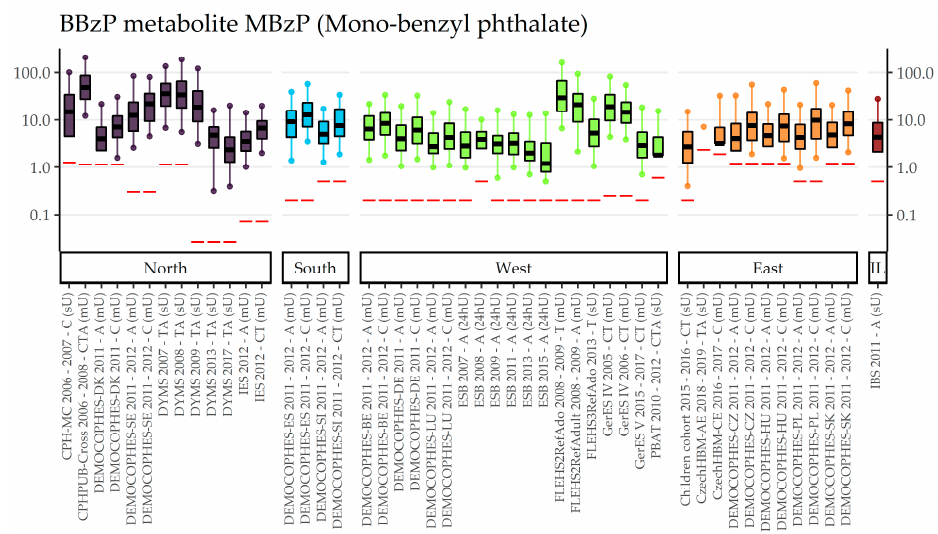
Figure 1. BBzP metabolite MBzP concentration in µ g/L in boxplots. The box is based on P25, P50, and P75, and the whiskers are based on P5 and P95. Boxplots are presented separately by regions (North = violet, South = blue, West = green, East = orange, Israel = dark red) within the regions chronologically sorted by year of sampling. Red lines denote LOQ/LOD for the respective study. Since percentiles are only available and displayed when they are above LOQ/LOD, the lower side of boxplots might be truncated. The age categories are shown in capital letters: children of the age groups 3–5 and 6–11 (C), adolescents between 12 and 19 years (T) and adults from the age groups 20–39, 40–59 and 60 years and older (A). The sampling method is indicated in brackets: first morning urine void (mU), spot urine (sU) and 24-hours urine